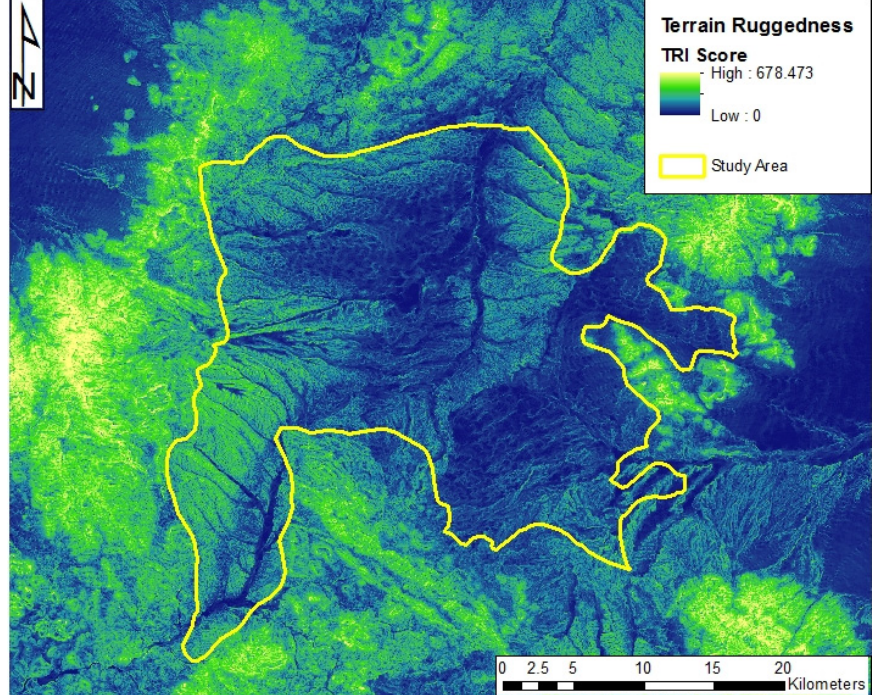
Figure 3. The Terrain Ruggedness Index (TRI) represents terrain heterogeneity in the Sonoita Plain (Index range is 0 to 4367